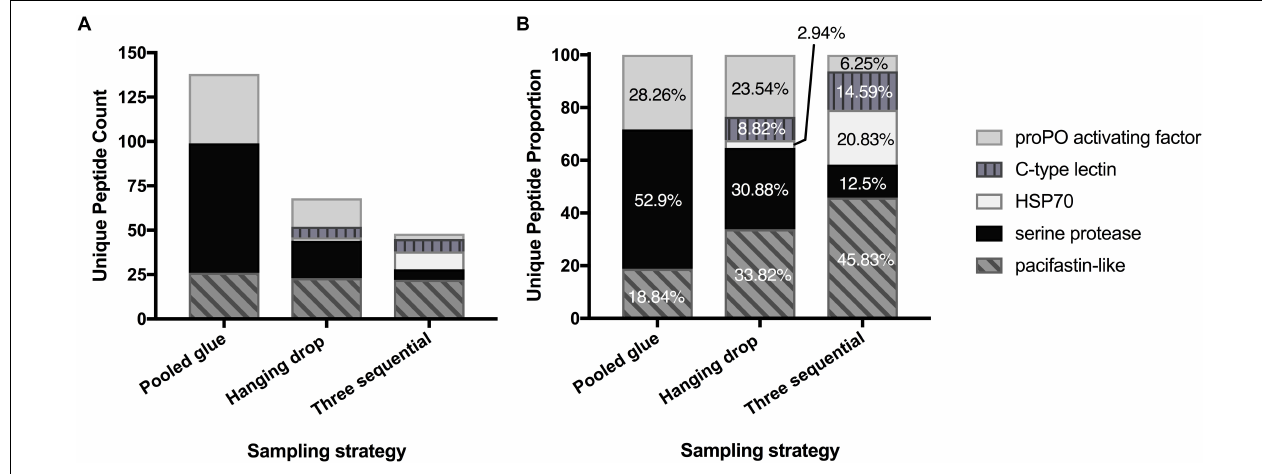
FIGURE 1 | Enrichment of key clotting-related proteins across the three experimental series. Distribution of unique peptides counts (A) and proportion of each (B) for five prevalent clotting proteins shared across experimental series.